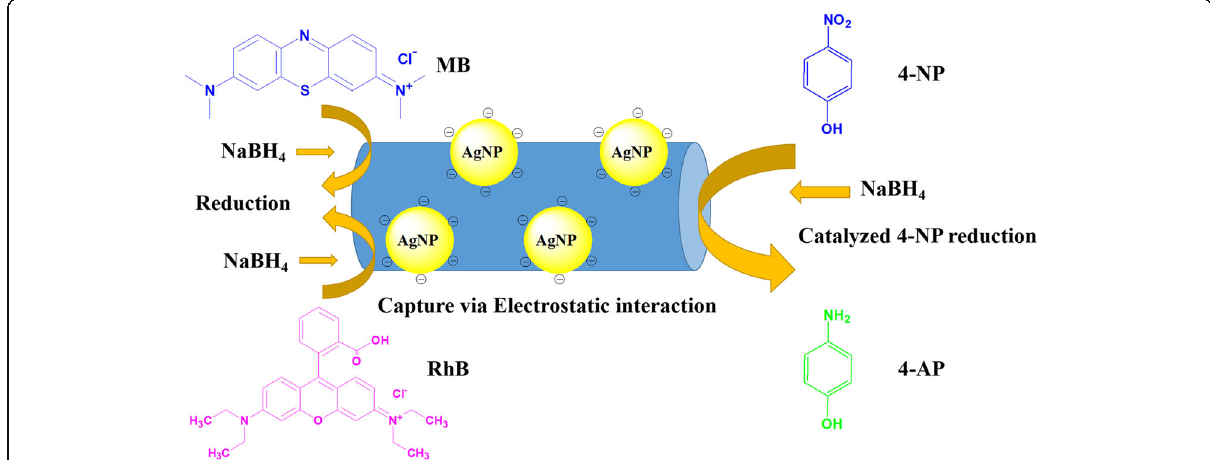
Fig. 8 Schematic illustration of the catalytic process via application of